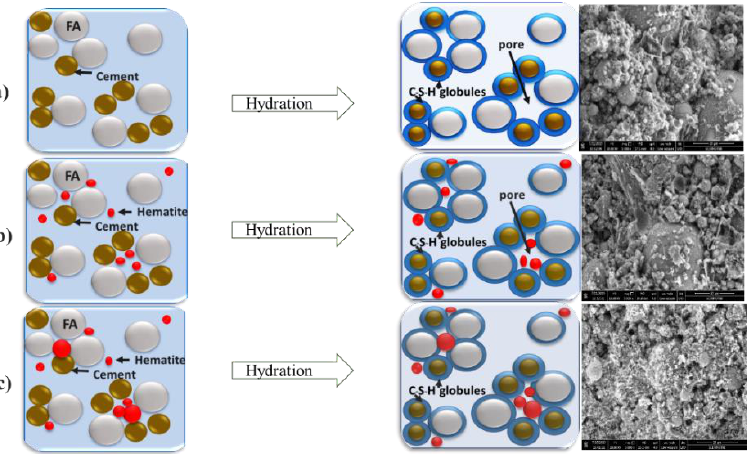
Figure 11. Schematic of cement hydration of ( a ) no α-Fe 2 O 3 , ( b ) α-Fe 2 O 3 in the narrow range particle size distribution and ( c ) α-Fe 2 O 3 in the broad particle size